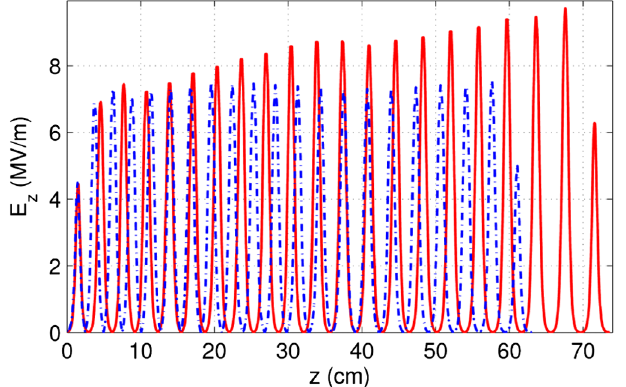
FIG. 13. Longitudinal electric-field profile along two tanks: IH1—blue dash dotted, and IH1m (modified tank discussed later in this section)—red solid